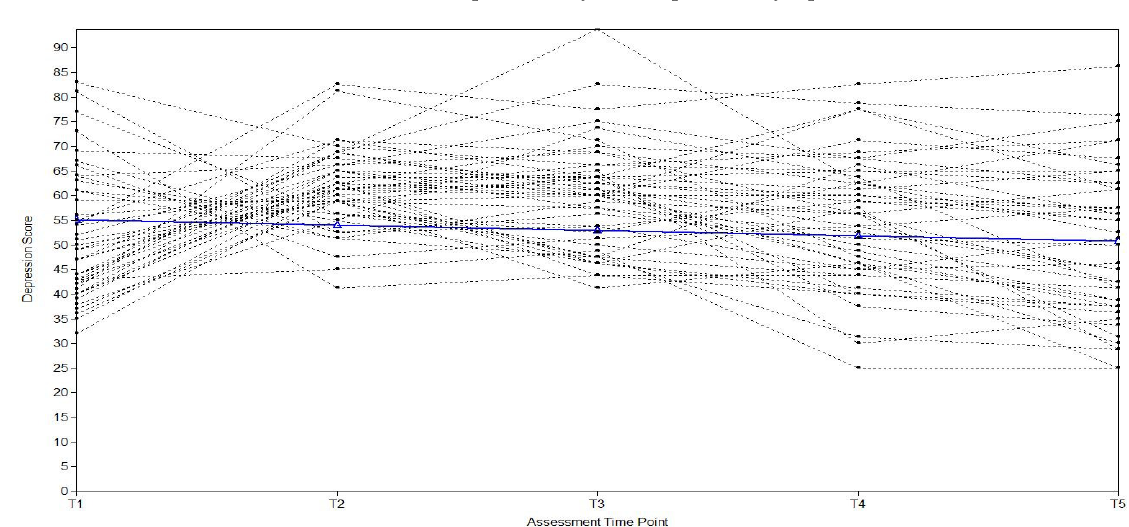
Figure 1. Estimated means and observed individual growth trajectories for each class.